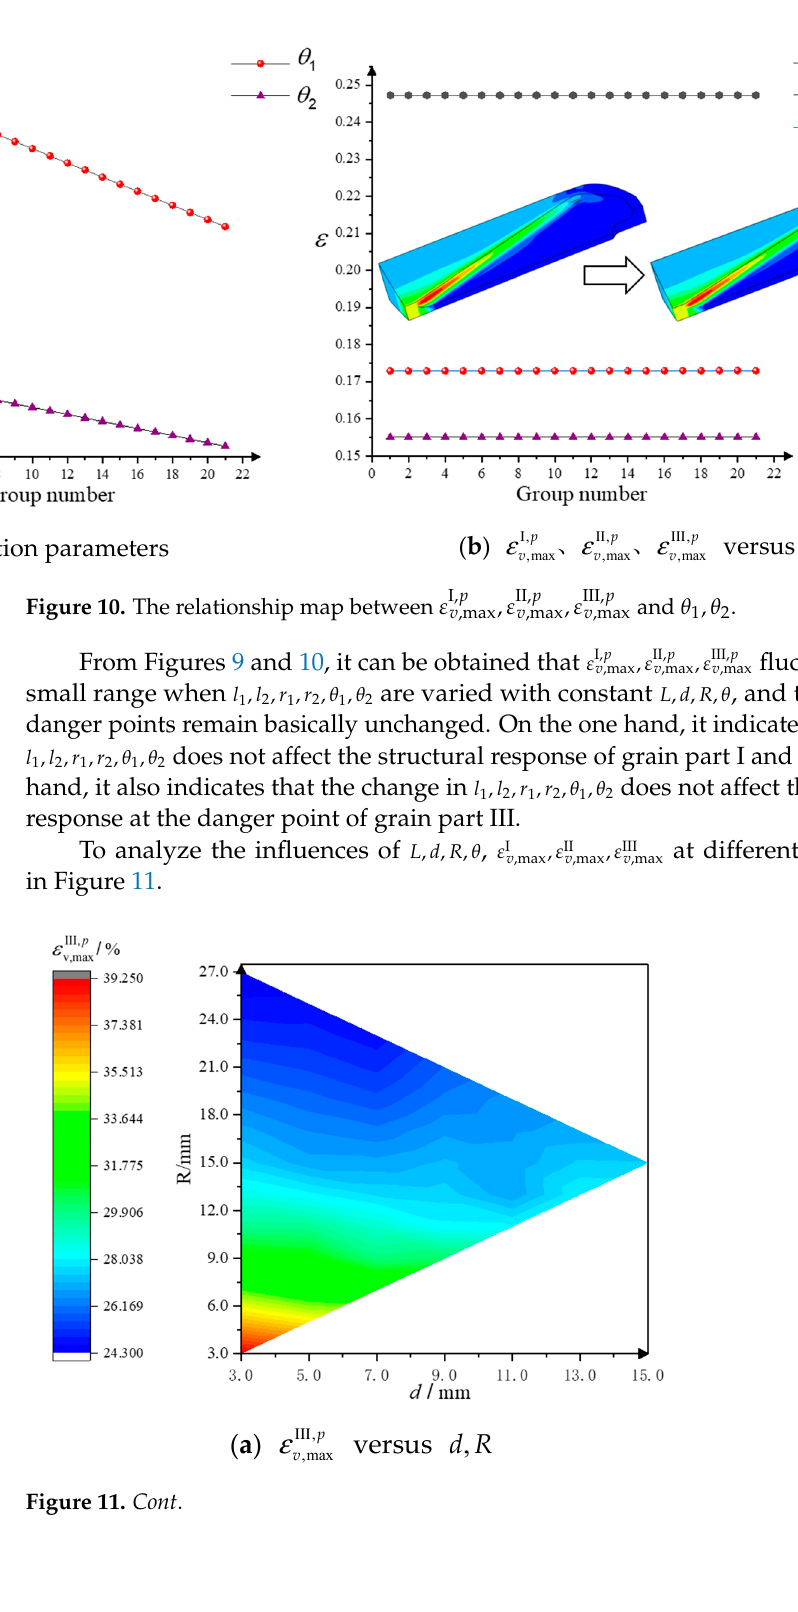
Figure 9. The relationship map between